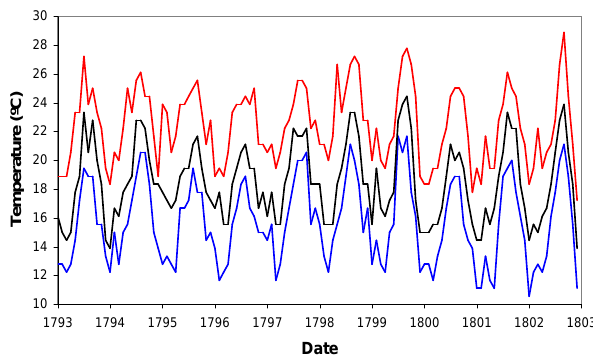
Fig. 5. Maxima (red), minima (blue) and mean (black) temperature Figure 5. Maxima (red), minima (blue) and mean (black) temperature at Madeira at Madeira recorded by Murdock from 1793 to 1802. recorded by Murdock from 1793 to 1802.